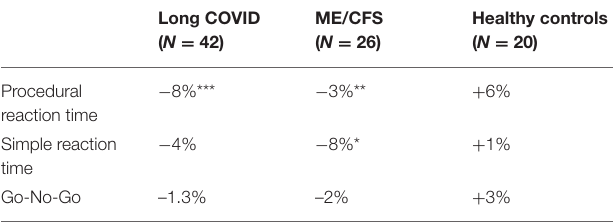
TABLE 3 | Percent change from baseline to immediately post-NASA Lean Test on three tests of reaction time, in people with Long COVID, ME/CFS and healthy